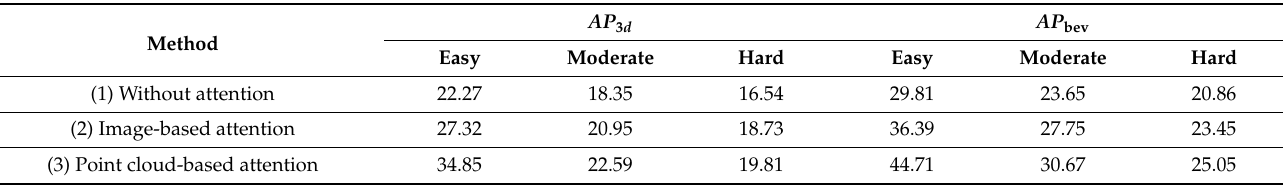
Table 7. Ablation study of attention